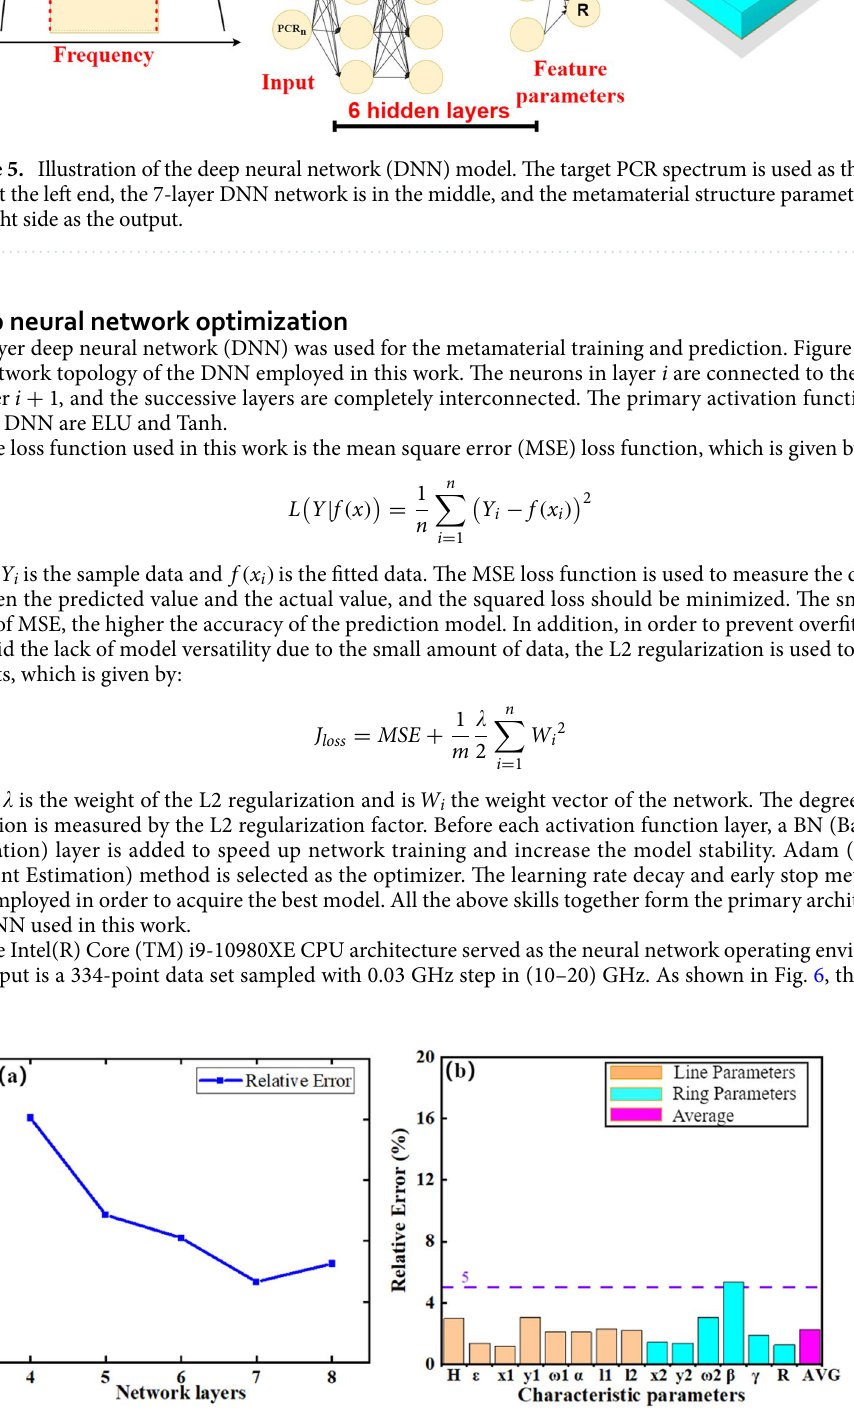
Figure 6. ( a ) The effect of the number of network layers on the network prediction error(based on ReLU); ( b ) Average prediction error of the 14 feature parameters given by the validation set (15 data sets). (Plotted in OriginPro